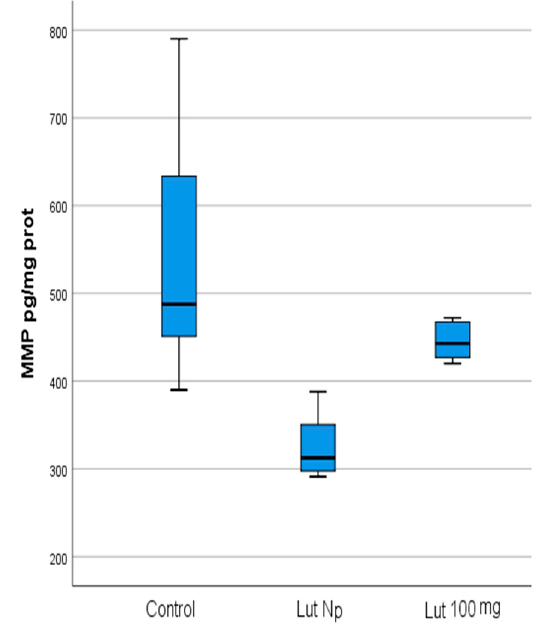
Figure 6. Comparison of FOXO-3 values (ng/mg protein) with regard to the batches of the studied OSSC cell lines (Lut 100—oral cancer squamous cells incubated with lutein (100 mg); Lut Nps—oral cancer squamous cells incubated with lutein nanoparticles; CR—control oral cancer squamous cells).